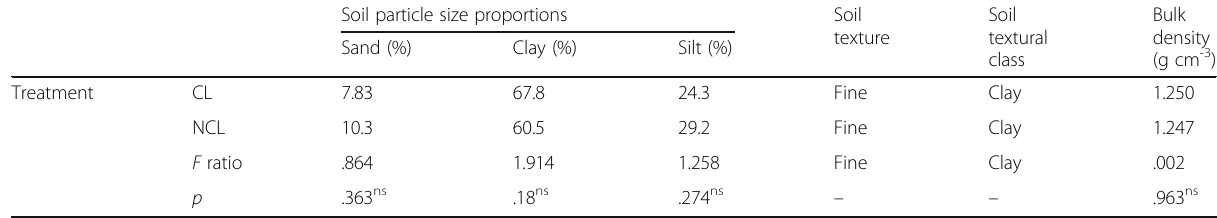
Table 2 The mean and their significant variations (one-way ANOVA) of soil physical properties in conserved and non-conserved